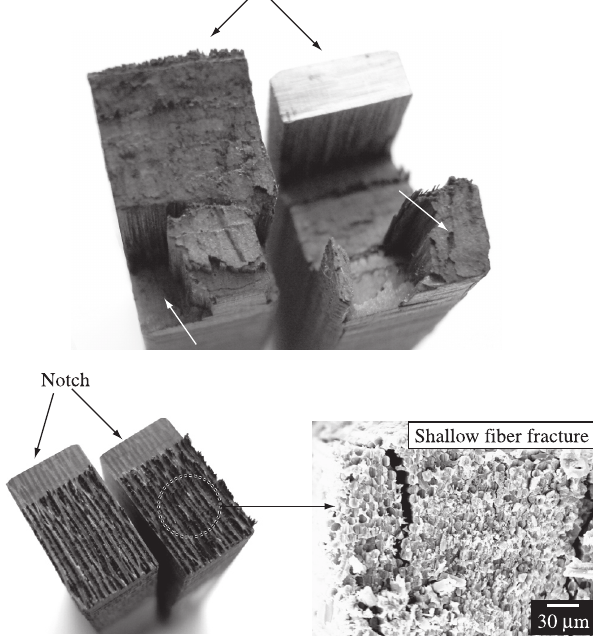
Figure 6. C-Ep fracture surfaces created under identical impact testing condi- tions: a) TP fiber architecture; b) FA fiber array; and c) detailed view of